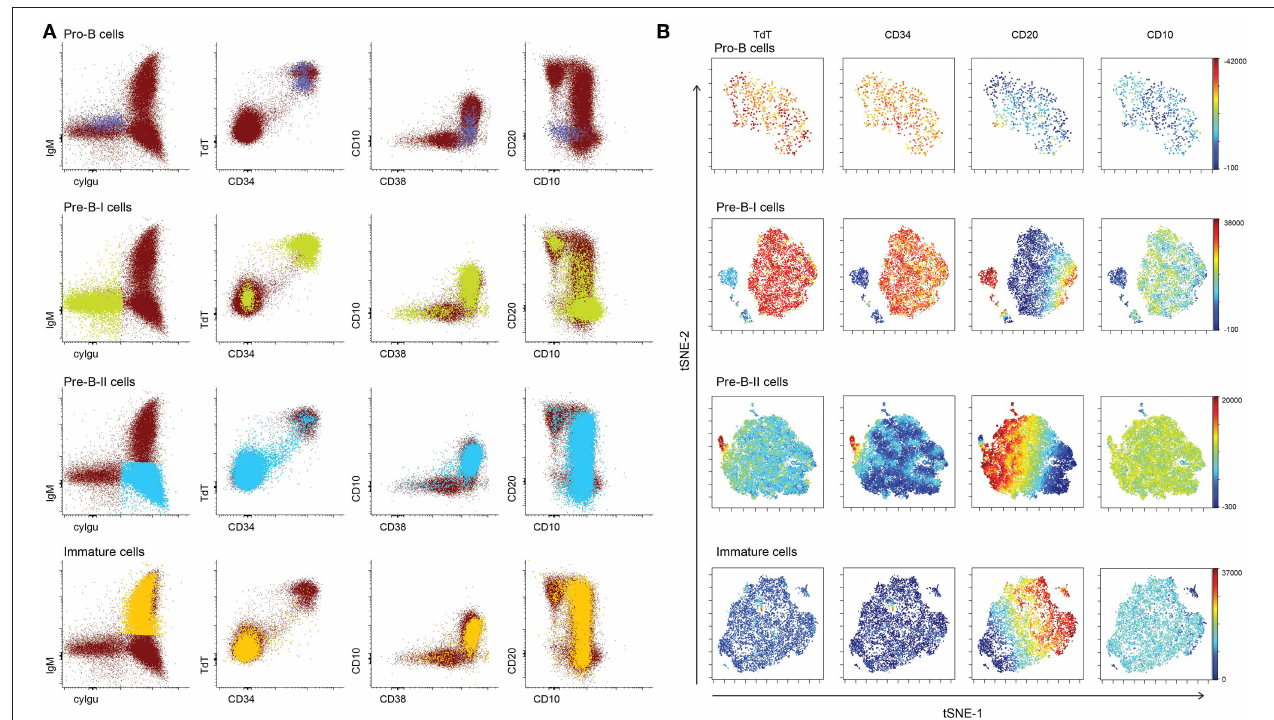
FIGURE 2 | Heterogeneity within BCP subsets. (A) Dotplots of a representative normal bone marrow sample, showing all cyCD79a + B cells in bone marrow. Populations of interest are highlighted in a different color: pro-B cells in pink, pre-B-I cells in green, pre-B-II cells in blue, immature cells in orange. (B) Results of a viSNE analysis of individual B-cell precursor subsets, represented by tSNE-1 vs. tSNE-2 plots. The color scale represents the intensity of the stain for individual markers: TdT, CD34, CD20, CD10, and